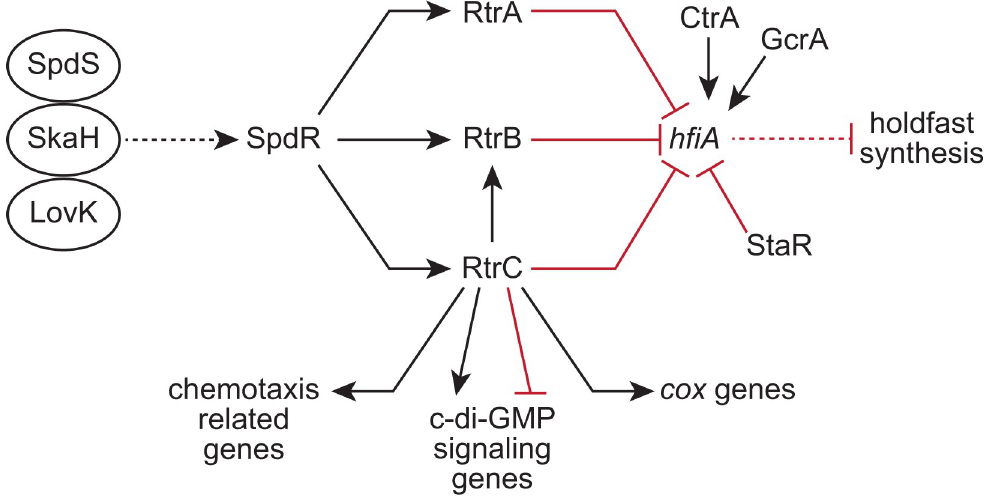
Fig 8. C . crescentus adhesion TCS regulatory network. The LovK, SkaH, and SpdS sensor histidine kinases function upstream of the DNA-binding response regulator, SpdR [16]. SpdR directly activates transcription of rtrA , rtrB , and rtrC . RtrA, RtrB, RtrC, and the XRE-family transcription factor, StaR, all directly repress hfiA transcription, while the cell cycle regulators CtrA and GcrA directly activate hfiA transcription. In addition to regulating hfiA , RtrC can function as a transcriptional activator and repressor for several groups of genes, including those with predicted roles in chemotaxis, c-di-GMP signaling, and aerobic respiration ( cox ). Dashed lines indicate post-transcriptional regulation, solid black arrows indicate transcriptional activation, and red bar-ended lines indicate transcriptional